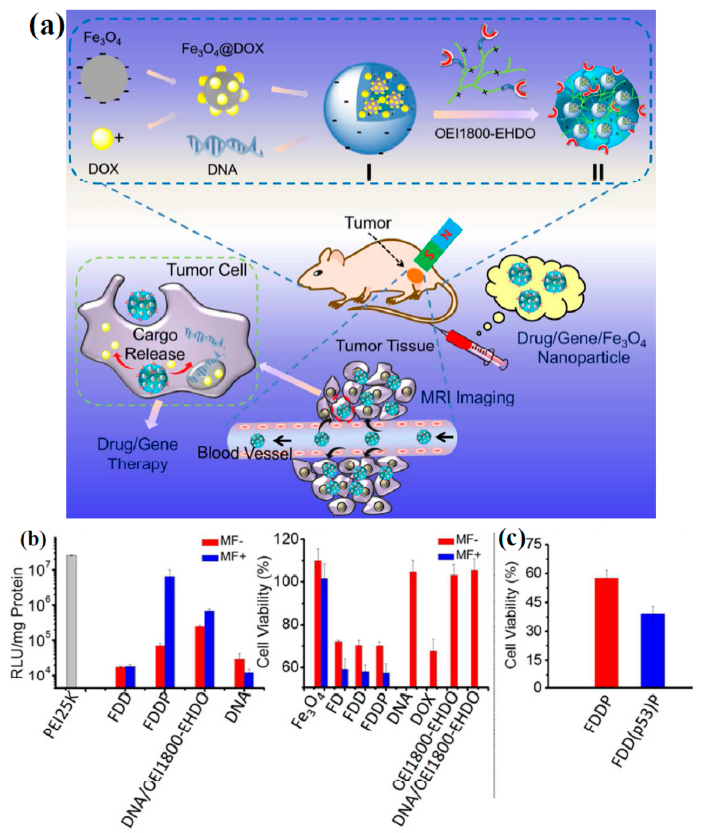
Figure 7. ( a ) Synthesis process of the Fe 3 O 4 @DOX/DNA/OEI1800-EHDO (FDDP) nanosystem for magnetic targeted drug/gene co-delivery and MRI; ( b ) transfection activity and cell cytotoxicity of various samples in HeLa cells after 30 min of treatment with/without magnetic field; and ( c ) cytotoxicity of DOX and pGL-3 co-loaded FDDP NPs and DOX and p53 co-loaded FDD(p53)P NPs in HeLa cells under magnetic field [129].